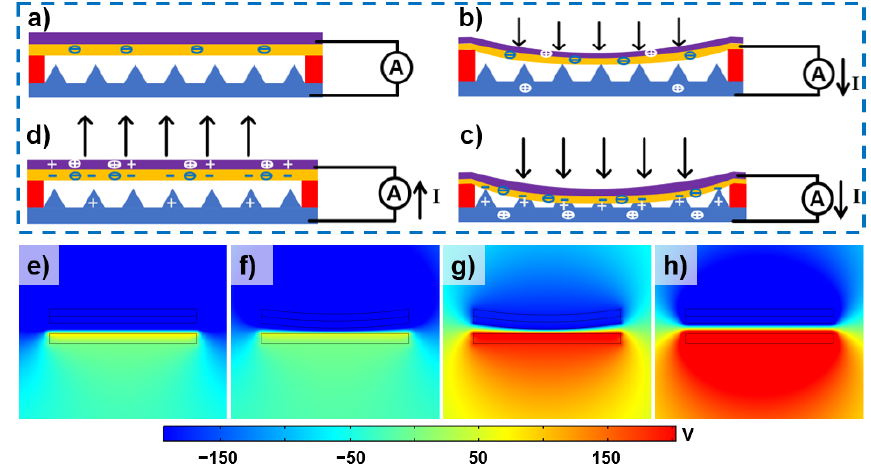
Figure 6. Working principle of the EHTS: Original ( a ), Compressing ( b ), Compressed ( c ) and recov ‐ ered ( d ) state; Electric field variation of EHTS during the compress ‐ recovery cycle ( e – h ). recovered ( d ) state; Electric field variation of EHTS during the compress-recovery cycle ( e – h